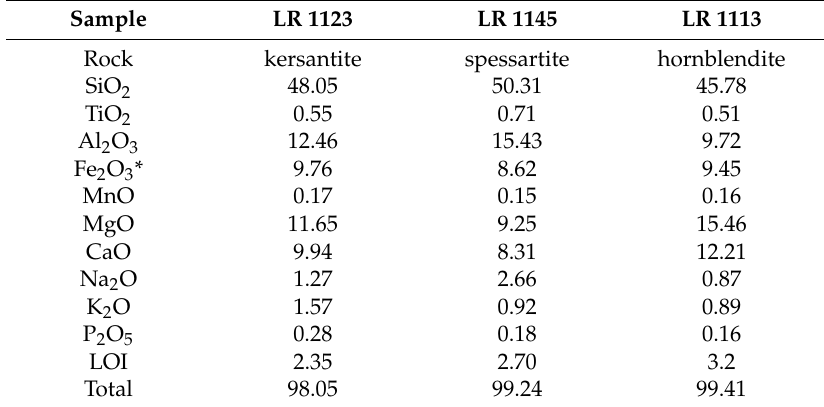
Table 1. Bulk rock composition of different rock varieties in the dyke.